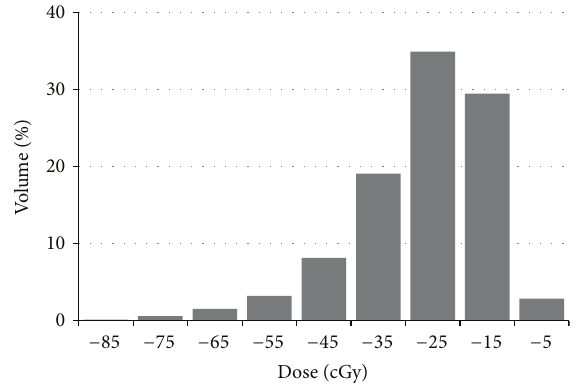
Figure 7: Prostate DVH for the error dose distribution shown in Figure 6(c). The bin size is